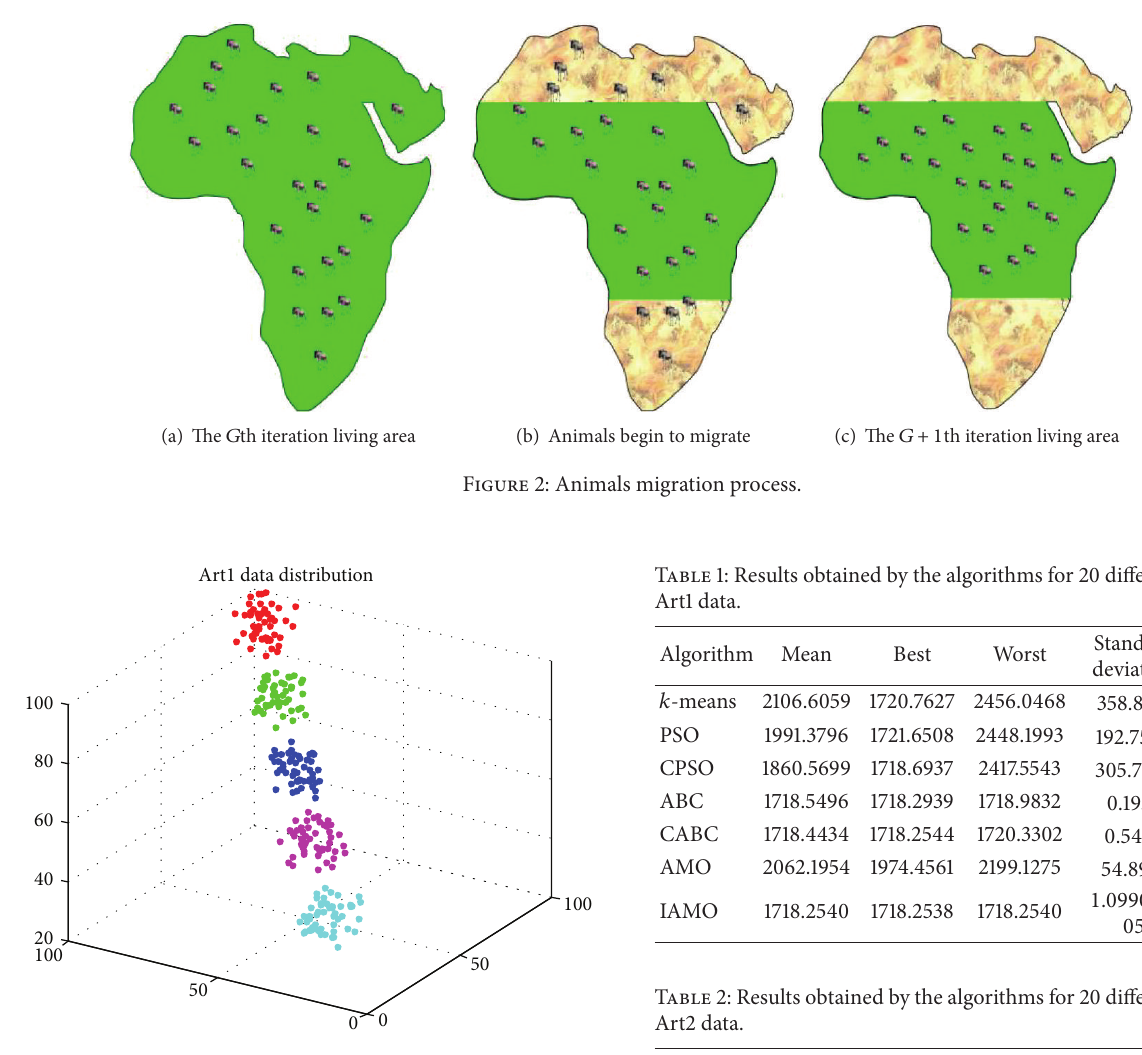
Figure 3: The distribution image of Art1.